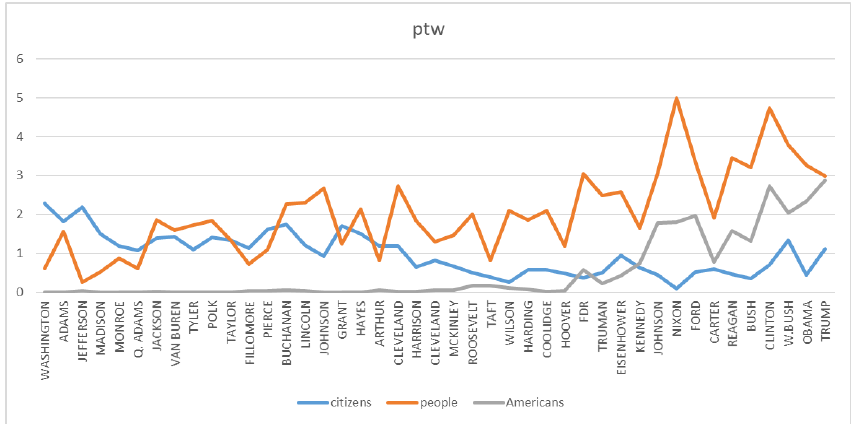
Figure 5. Normalized frequencies (per thousand words) of citizens , people and Americans by president.